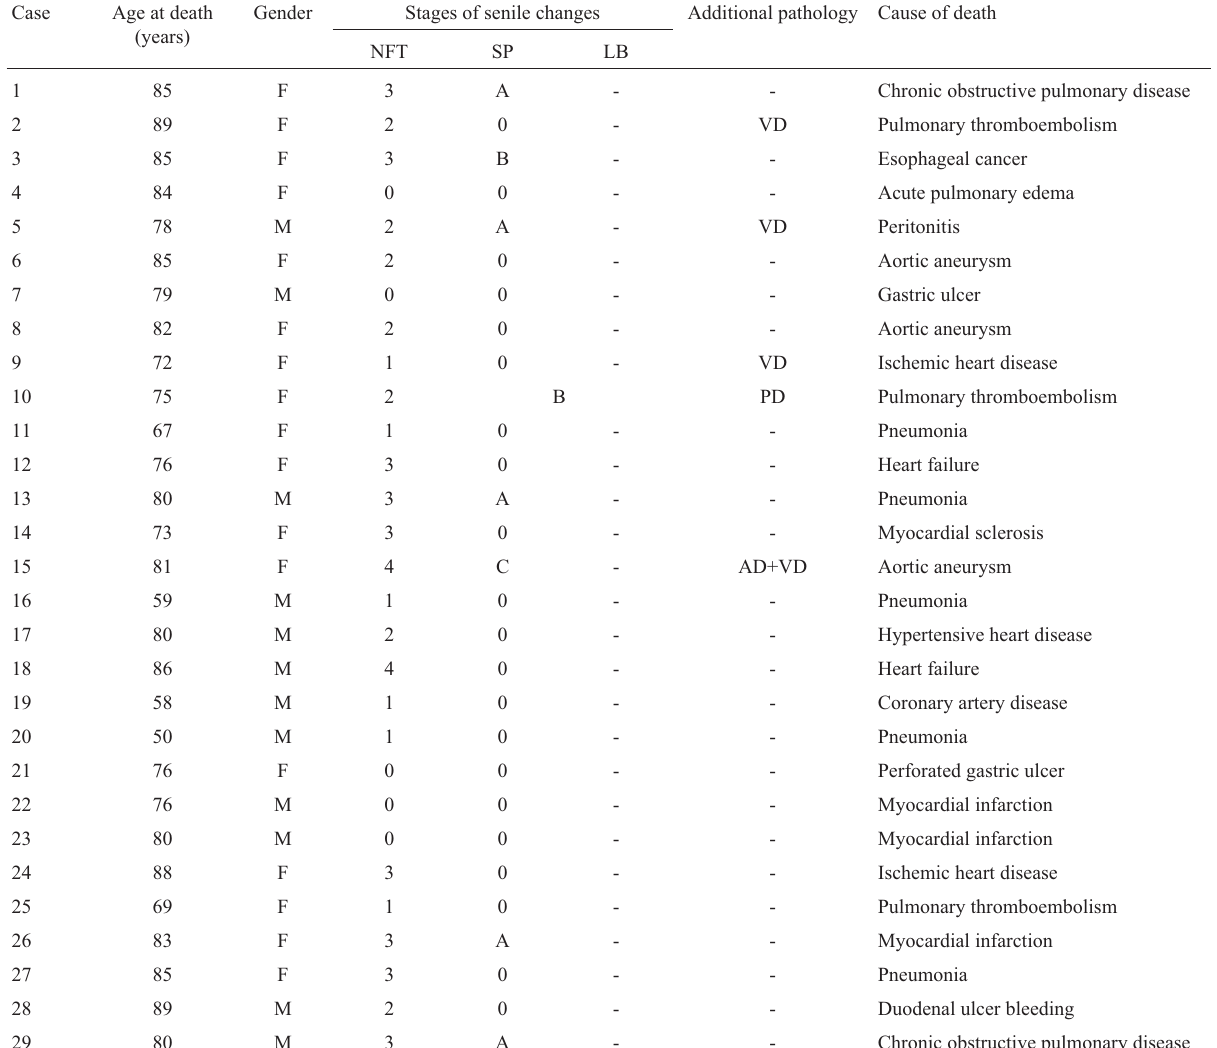
Table 1 - Case profiles of the all subjects with Argyrophilic grain disease investigated in this study. Case Age at death